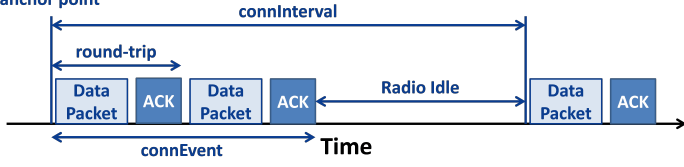
Figure 8. Example of a round-trip data communication in a connection with the transmission of data packets and ACKs. In this figure are described all the connection